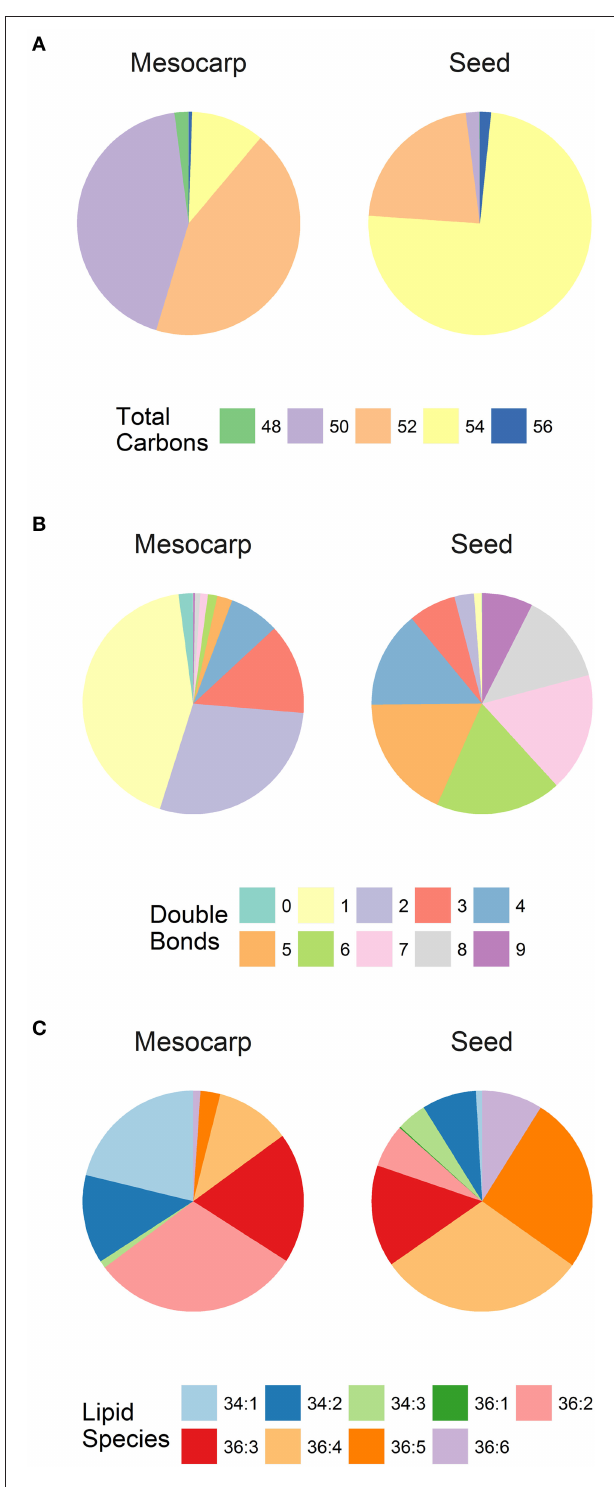
FIGURE 4 | The composition of neutral lipids in Triadica sebifera LD isolated from stage III immature mesocarp and seed kernel. (A) Total carbon chain length of TAG species; (B) Number of double bonds in TAG species; (C) DAG lipid